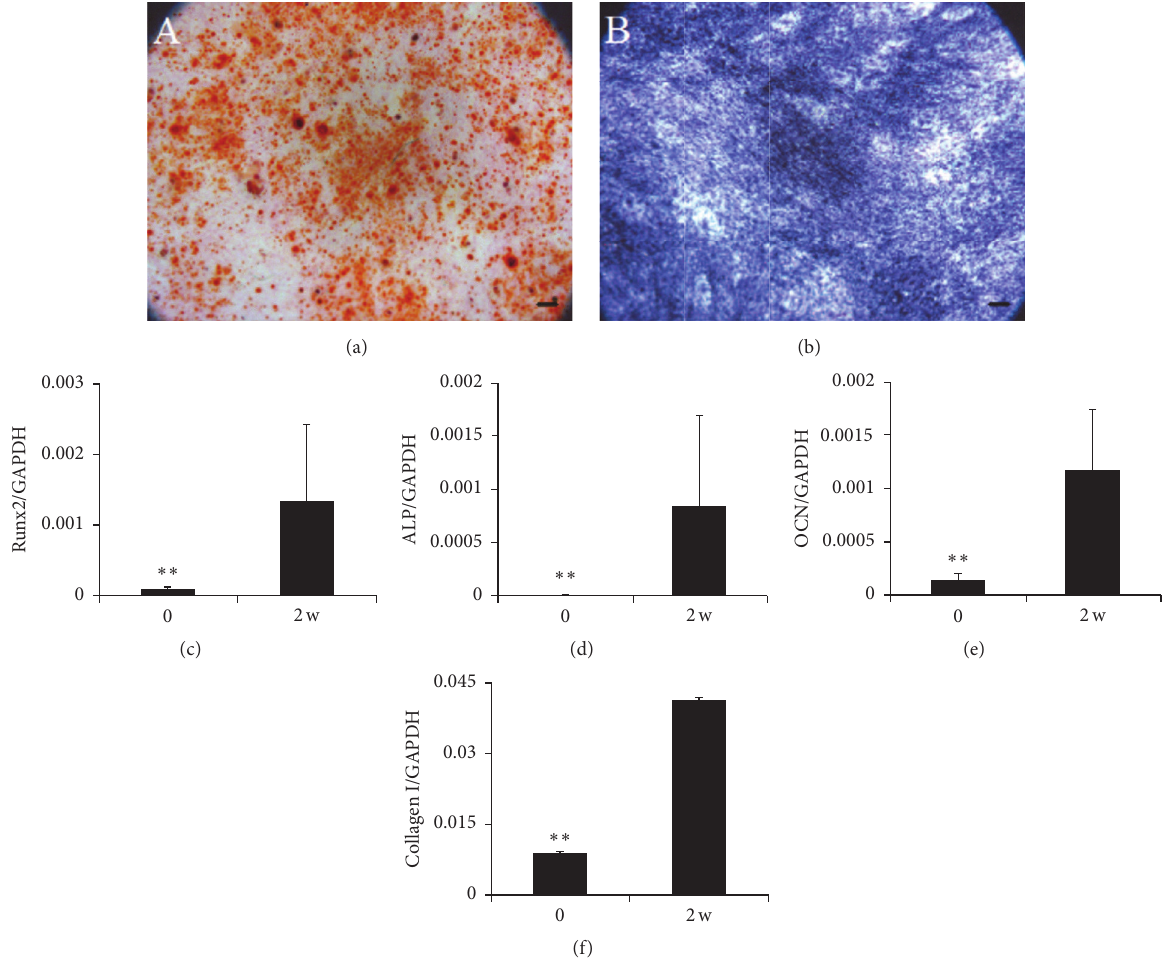
Figure 3: Osteogenic differentiation potential of third-passage MSCs cultures derived from meniscal debris. After 14-day induction in osteogenic medium, osteogenesis was determined based on deposition of matrix calcification detected by Alizarin Red (a) and based on ALP-specific staining (b). Scale bar = 100 𝜇 m. Expression of osteogenic genes encoding Runx2 (c), ALP (d), OCN, (e) and type I collagen (f) was assessed using real-time PCR. Data are presented as mean ± SD. ∗∗ 𝑃 < .01